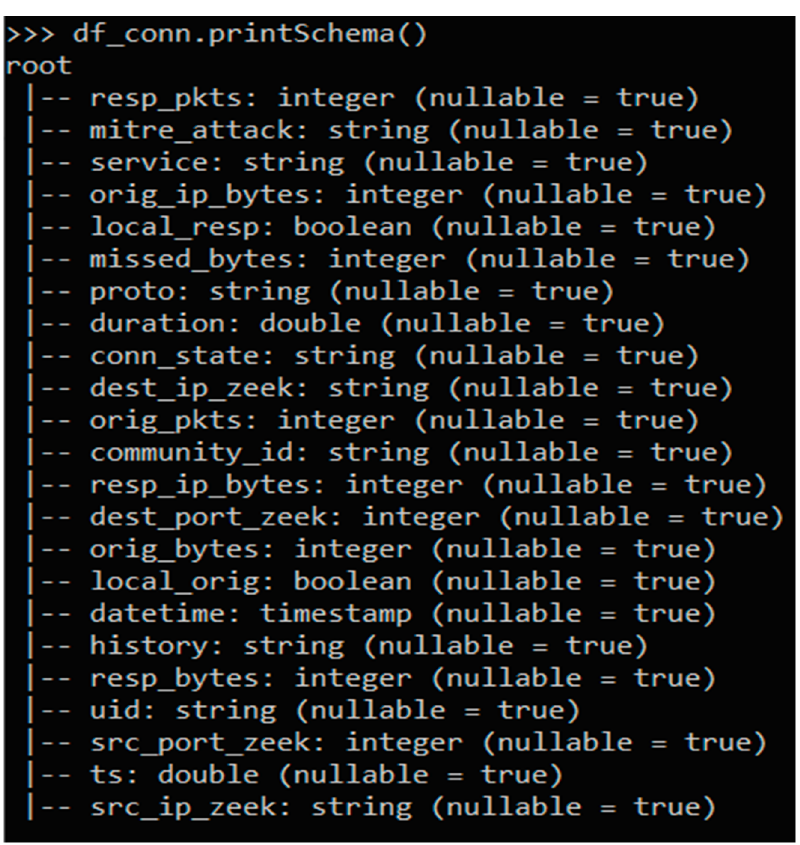
Figure 1. Schema of Conn Log File.